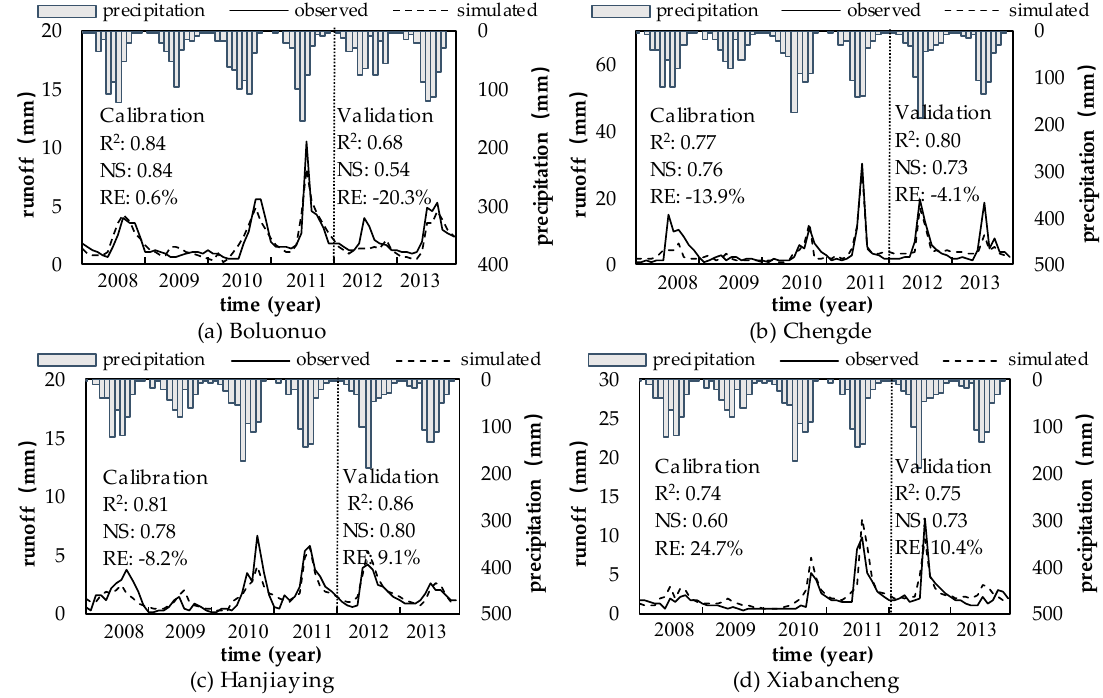
Figure 3. Comparison of the observed monthly runoff and simulated monthly runoff in hydrological stations: ( a ) Boluonuo, ( b ) Chengde, ( c ) Hanjiaying, ( d ) Xiabancheng.